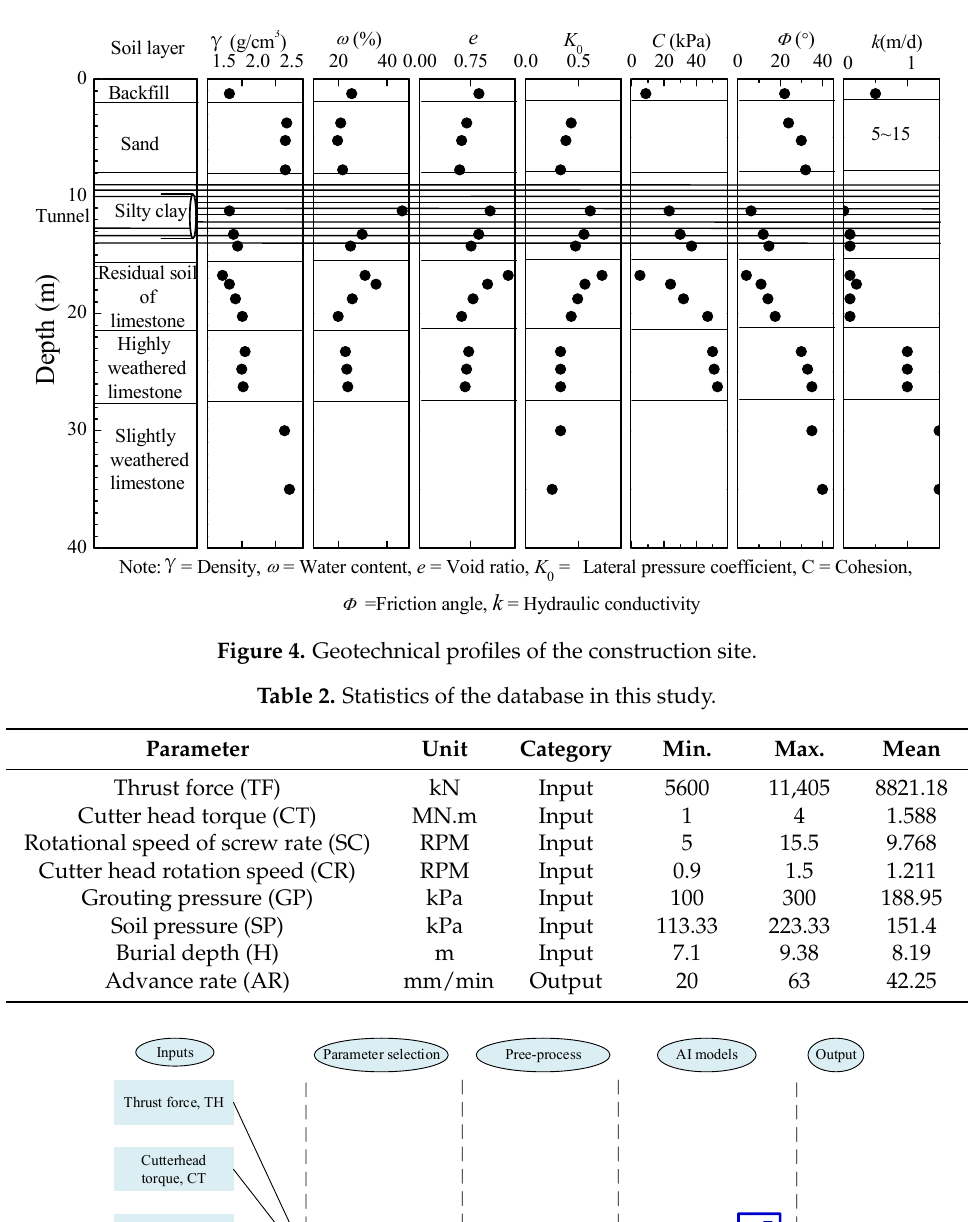
Figure 5. Schematic steps for predicting tunnel boring machines (TBM) performance.